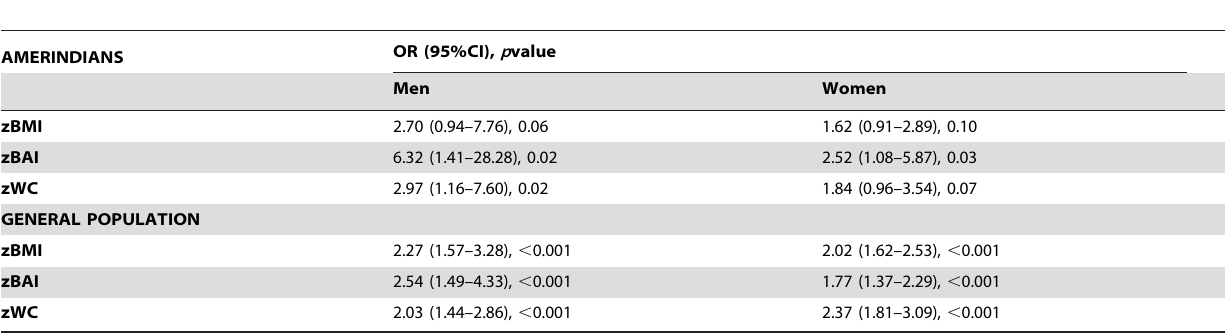
Table 3. Risk assessment for T2DM according to zBMI, zBAI and zWC in Amerindian and General population.